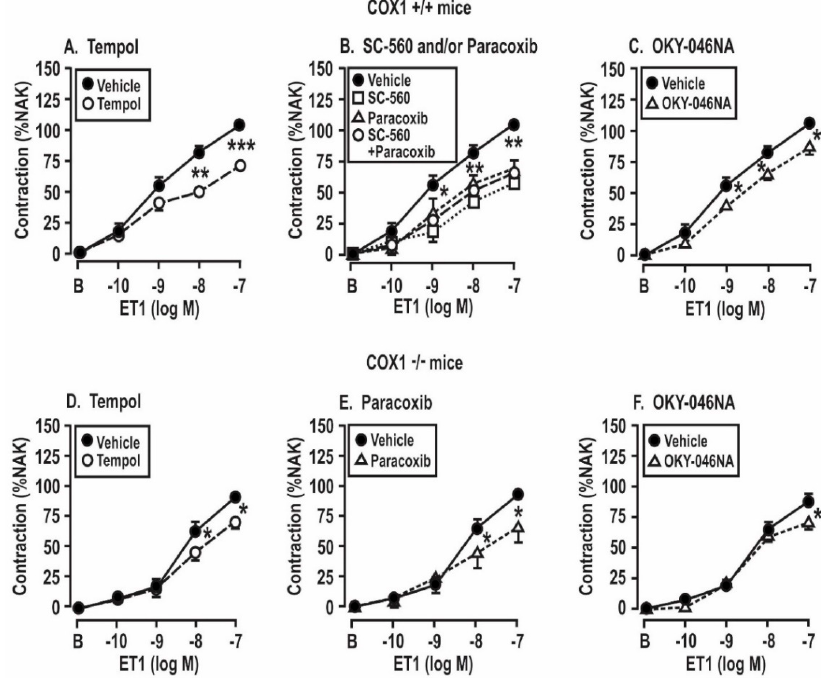
Figure 5. Contractions to endothelin 1 in mesenteric resistance arterioles from mice with angiotensin II infusion at 400 ng·kg –1 ·min –1 sc × 14 days are reduced by the metabolism of reactive oxygen species (A, D) or by the blockade of cyclooxygenase 1 (B, E) or thromboxane synthase (C, F) in vessels from COX1 +/+ mice, but the effects are reduced in vessels from COX1 − / − mice. Mean ± SEM values ( n = 6 per group) for the vascular contractions to endothelin 1. B, before; %NAK compared to standard vascular contraction with norepinephrine and high KCl. Comparing groups: *, P < 0.05; **, P < 0.01; ***, P < 0.005. The control data are reproduced from Figure 4. Table 3. Contractions to endothelin 1 (ET-1) in mesenteric resistance arterioles (MRA) incubated with physiological salt solution (PSS) or with drugs that block ROS (tempol), cyclooxygenase 1 (SC-560), cyclooxygenase 2 (paracoxib), or thromboxane A 2 synthase (OKY-046). E ff ects of infusion of a vehicle or angiotensin II at a slow pressor rate for two weeks and of thromboxane prostanoid receptors (TPRs) or cyclooxygenase 1 (COX1).